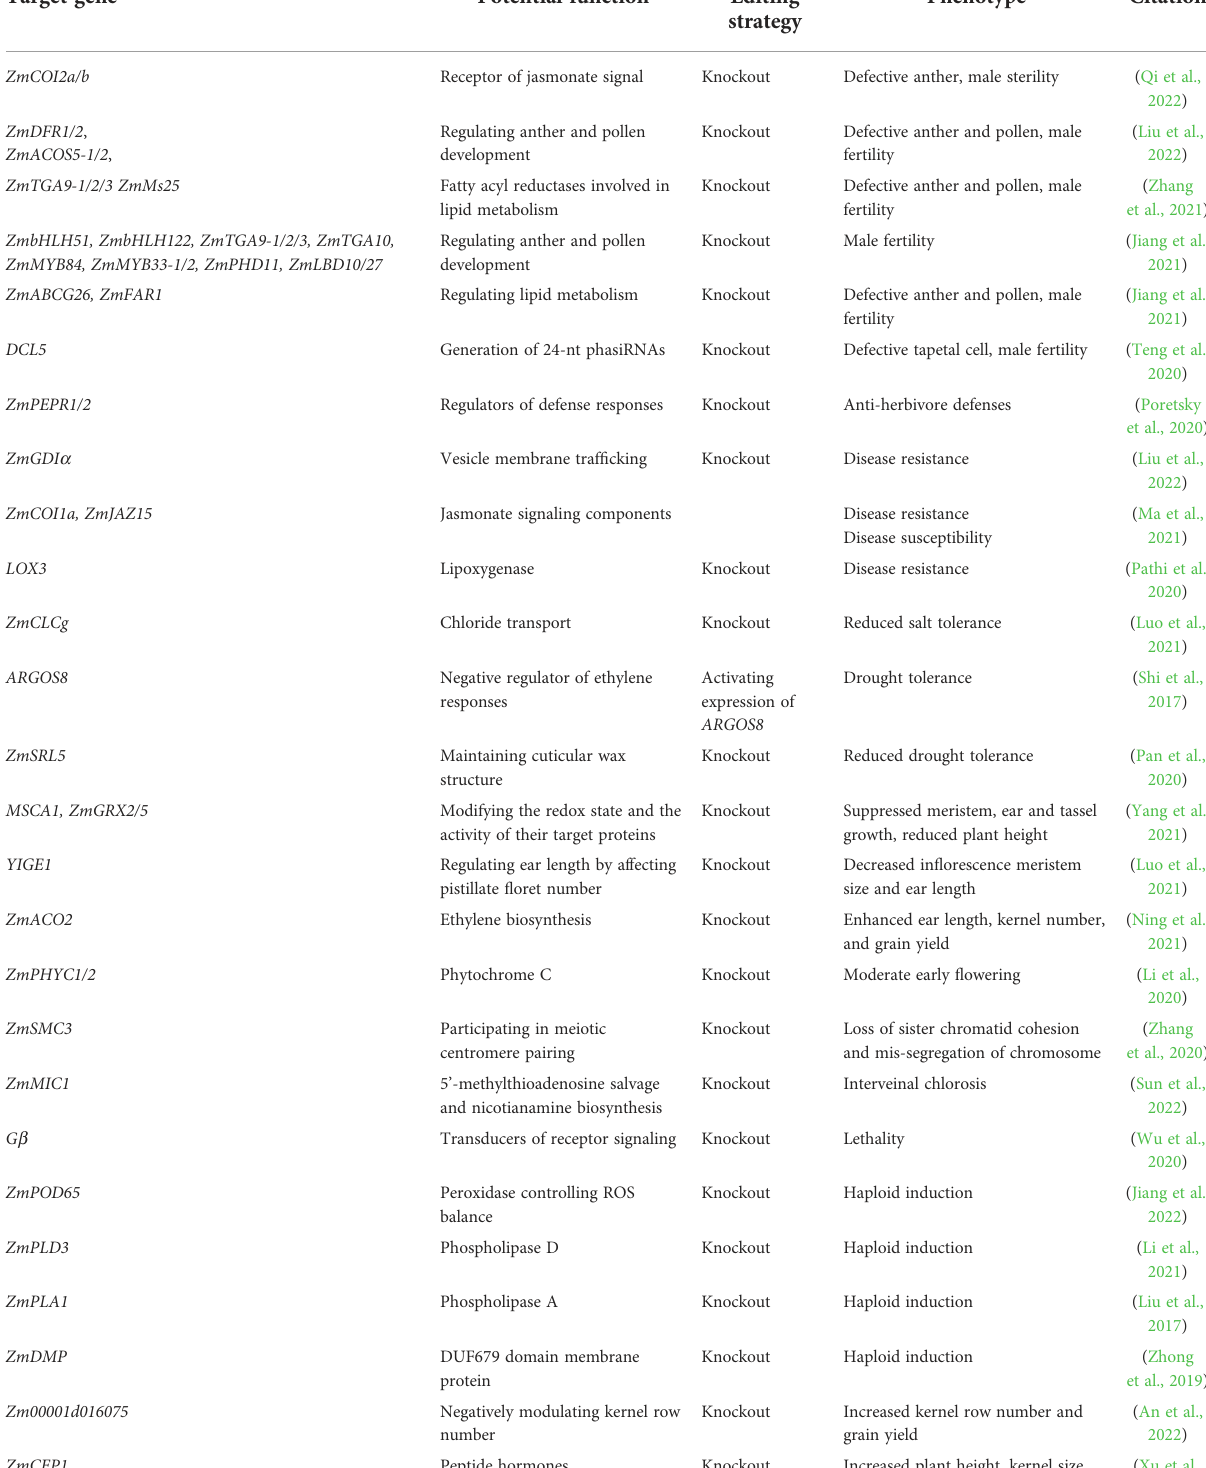
TABLE 1 The potential functions and utilizations of key genes annotated by CRISPR-Cas